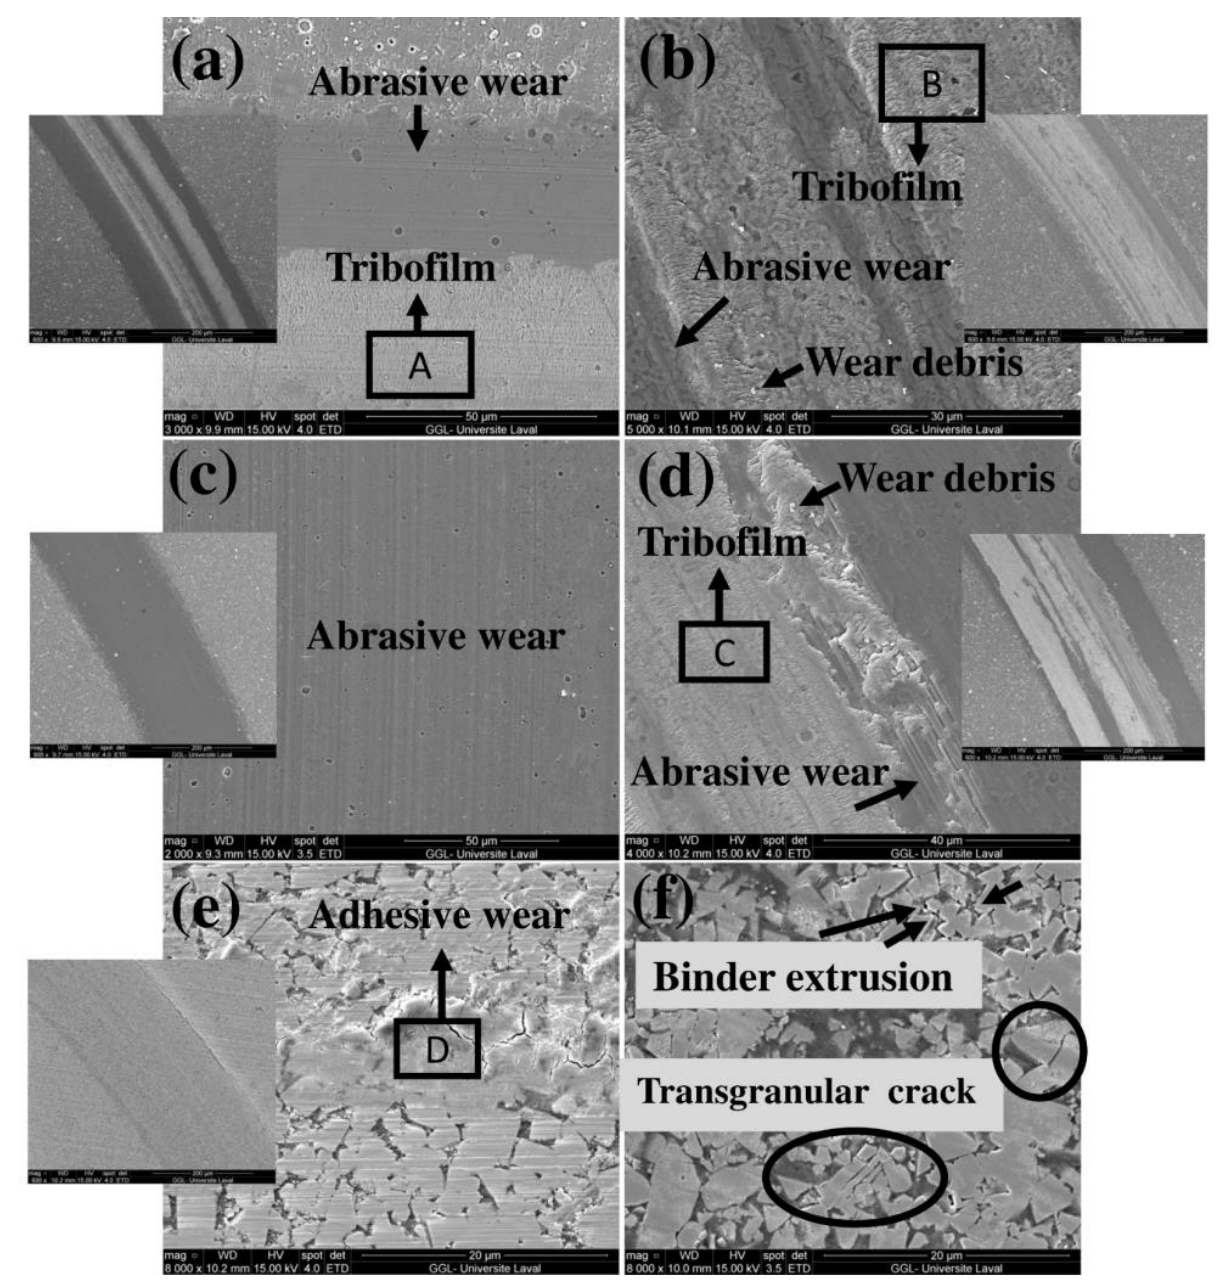
Figure 15. SEM micrographs of the wear track surface of different coatings at the sliding speed of 50 mm/s ( a ) CrN/CrCN/DLC, ( b ) CrN/AlTiN, ( c ) CrN/CrCN, ( d ) CrCN/TiSiCN, and ( e , f ) uncoated WC-Co substrate.